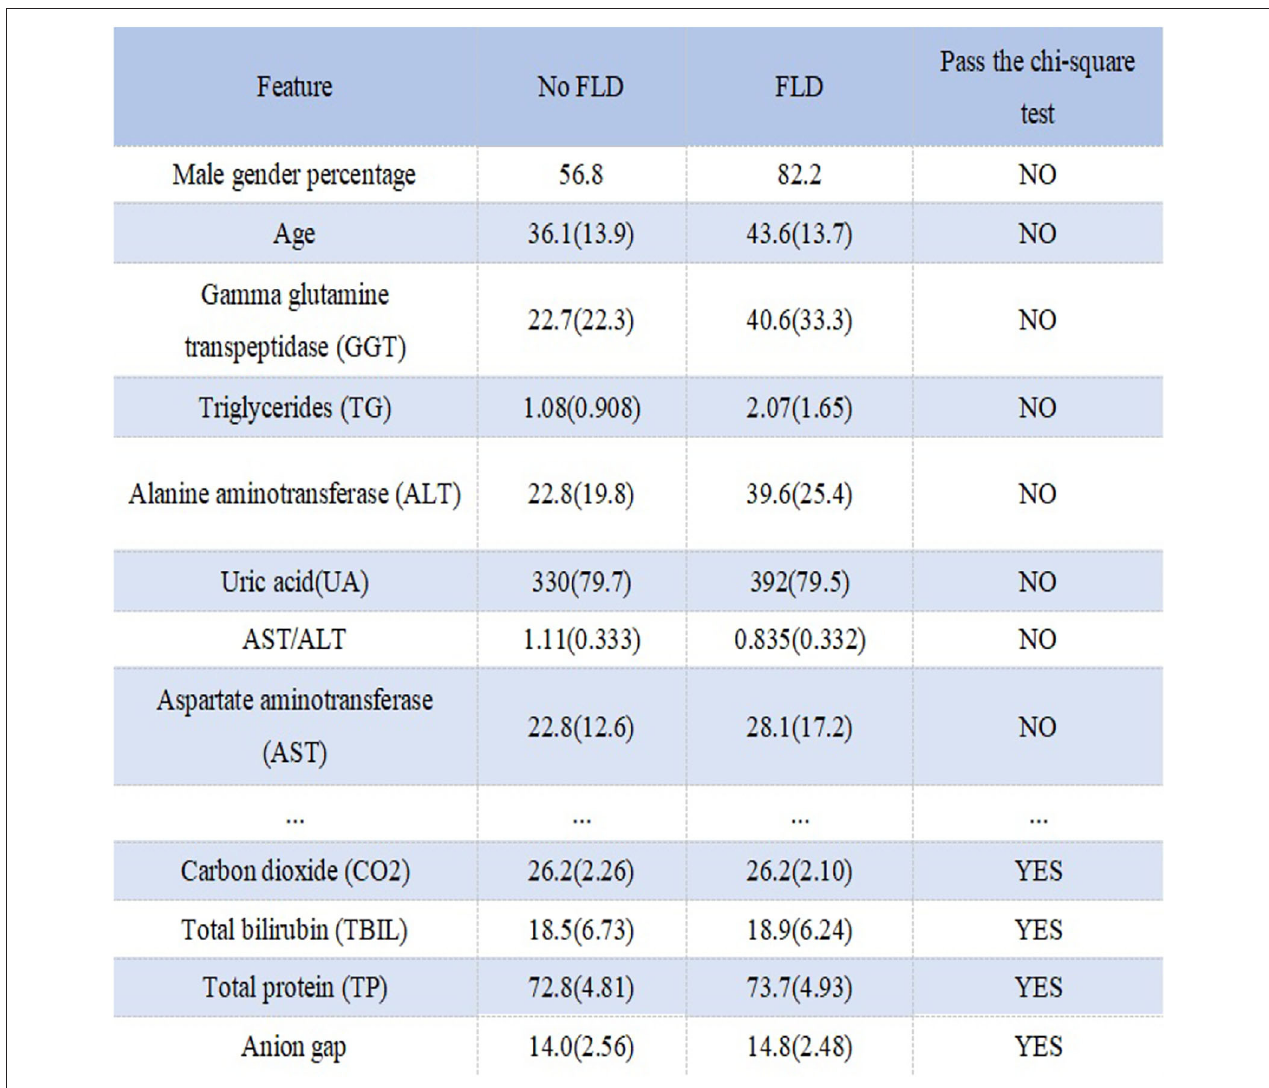
FIGURE 2 | Statistical information and chi-square test results of different features in different groups.